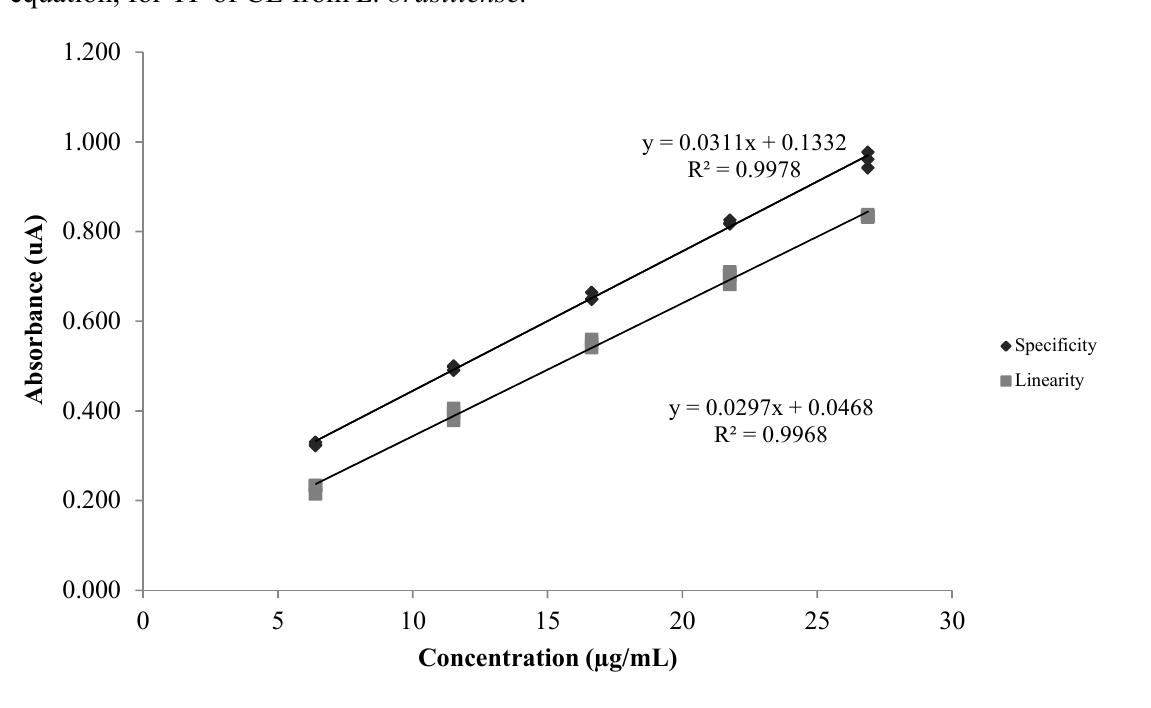
Figure 4. Linearity curve and specificity curve, with correlation coefficient (R 2 ) and linear equation, for TP of CE from L.